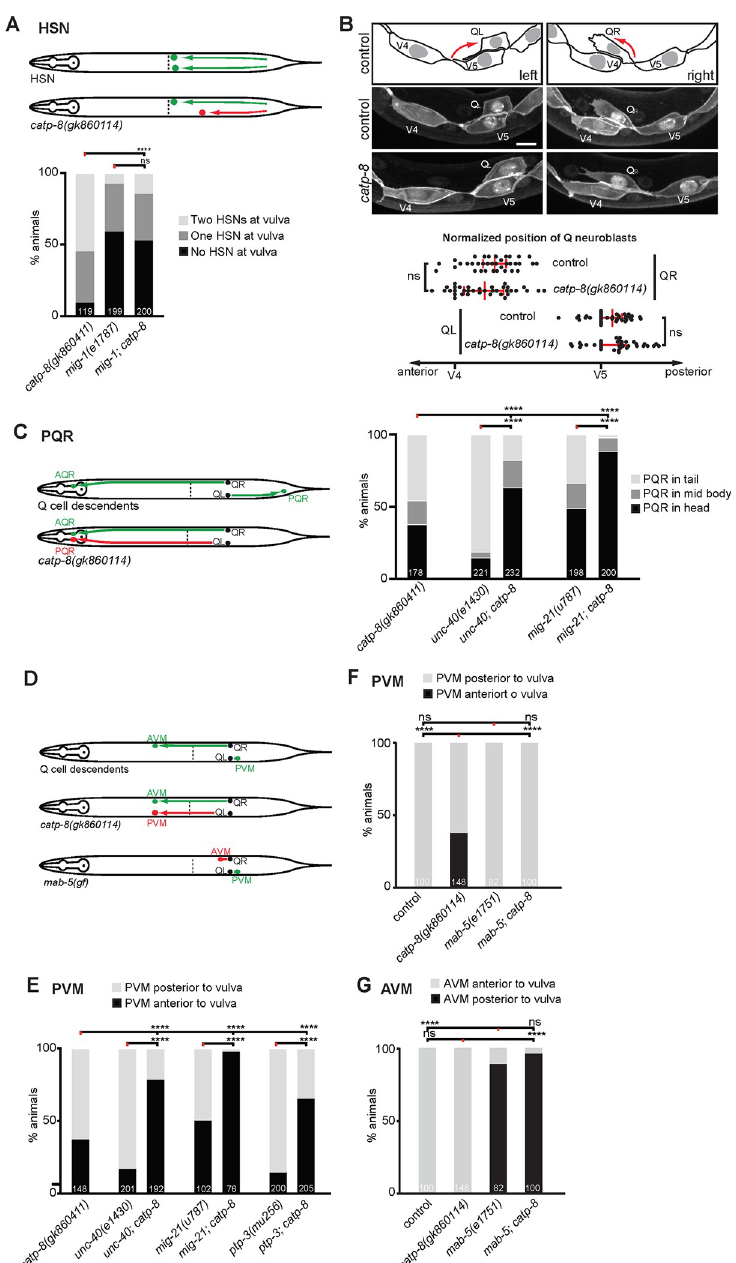
Fig 7. Genetic interactions of catp-8/P5A ATPase during cell migrations. A. Schematics depicting normal HSN migration (upper panel) and HSN migration defects (lower panel), and quantification of HSN migration defects in the genotypes indicated. Percent animals are shown with neurons in the wild type position (light grey bars), partially incomplete migration (dark grey bars) and completely failed migration (black bars). Pairwise statistical significance was calculated using Chi-squared test or Fisher exact test. ���� P � 0.0001, ns not significant. Sample size indicated on graph. B. Schematic, images and quantification of the relative position of initial Q neuroblast migration in the genotypes indicated, imaged 4.5 hours after hatching. Scale bar = 5 μ m. Data are represented as the mean ± 95% confidence interval. ns not significant; Mann-Whitney test. n = 35 animals per genotype. C. Schematics depicting normal PQR migration (upper panel) and migration defects (lower panel), and quantification of PQR migration defects in the genotypes indicated. Percent animals are shown with neurons in the wild type position (light grey bars), partially incomplete migration (dark grey bars) and completely failed migration (black bars). Pairwise statistical significance was calculated using Chi-squared test or Fisher exact test. ���� P � 0.0001. Sample size indicated on graph. D. Schematics depicting normal AVM and PVM migration (upper panel) and migration defects (middle and